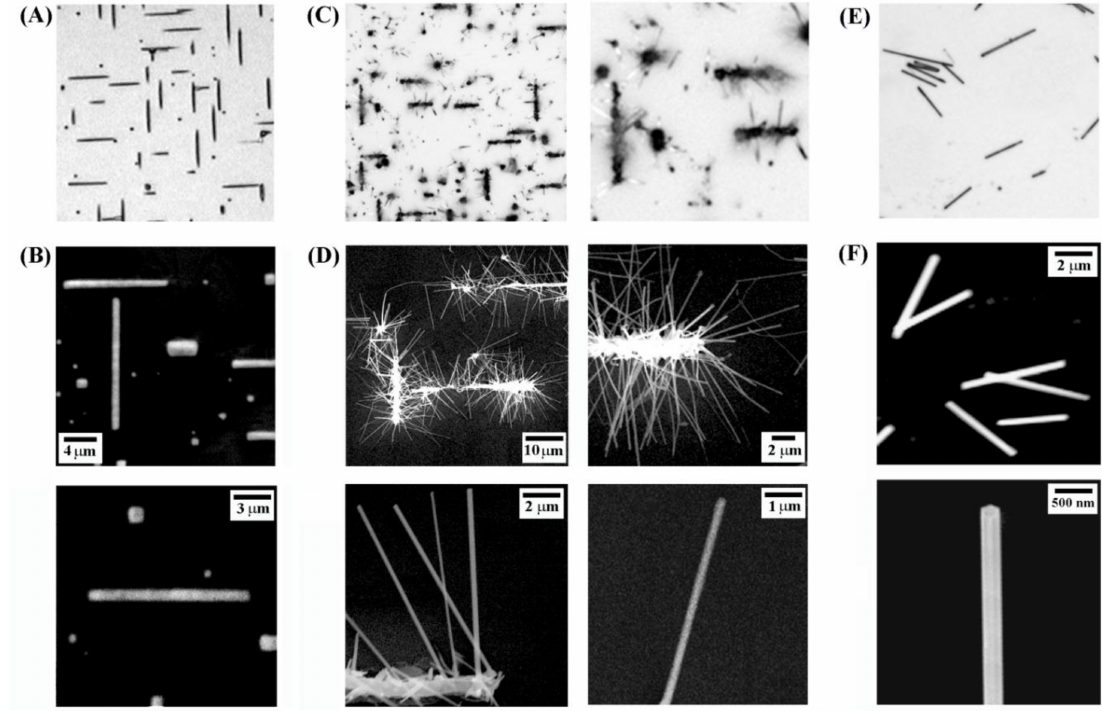
Figure 1. Bright-field and SEM images showing the structures of Cu 3 Si nanoblock (NB) catalysts, ZnO nanorods (NRs) grown on Cu 3 Si NBs (Cu-doped ZnO NRs), and ZnO NRs grown on Au nanoparticles (NPs) (undoped ZnO NRs). ( A , B ) As-synthesized Cu 3 Si NBs on Si. Upon CVD, Cu 3 Si NBs nucleate and self-assemble into NBs on the Si(100) growth substrate, as shown in the optical ( A ) and SEM ( B ) panels; ( C , D ) As-synthesized Cu 3 Si NBs on Si such as the ones displayed in ( A , B ) were used as catalysts to directly grow ZnO NRs on the NBs. Cu-doped ZnO NRs can be successfully produced on Cu 3 Si NBs, seen as brushlike structures in the bright-field image in ( C ); The wire-like shape of the Cu-doped ZnO NRs extended from a Cu 3 Si NB base can be clearly seen in the zoomed-in SEM panels in ( D ); ( E , F ) The optical and SEM panels in ( E , F ), respectively, are typical images of undoped ZnO NRs produced by using Au NP catalysts. The second row of panels shown in ( B – F ) displays zoomed-in views of the nanostructures shown in the first row